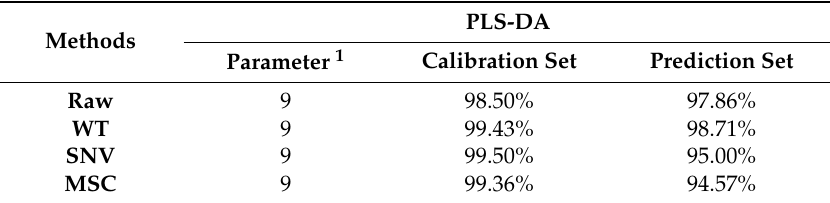
Table 1. Comparison of discrimination performance obtained by partial least squares discriminant analysis (PLS-DA) with different preprocessing methods using full